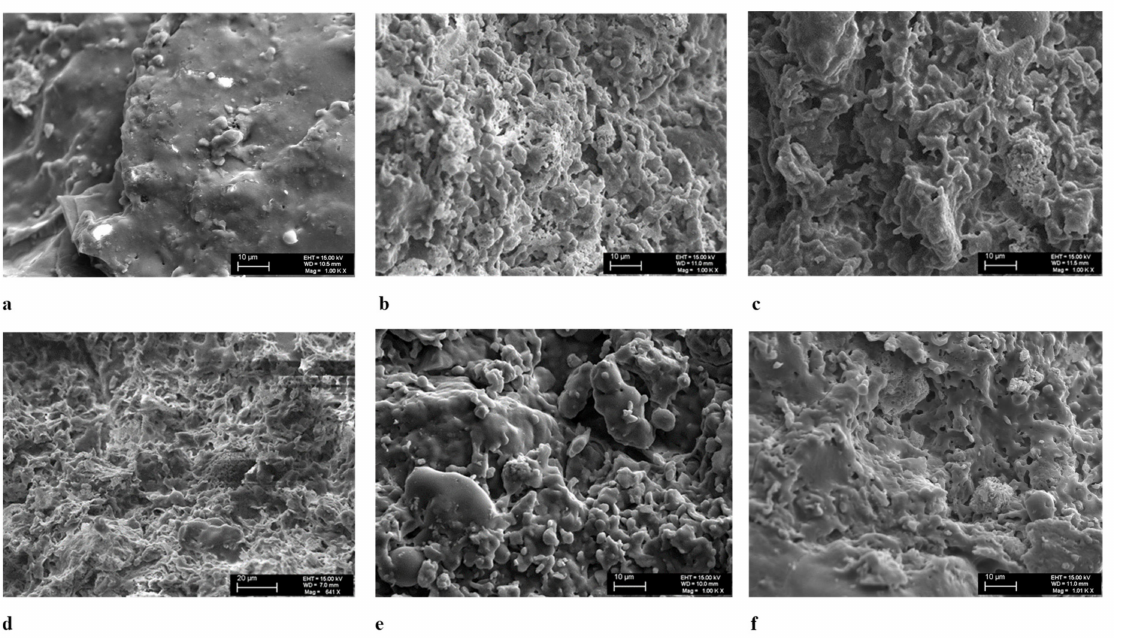
Figure 6. SEM photos of the samples thermally treated at 1050 ◦ C: ( a ) Arumetsa + 40%f(A), ( b ) A + 40% Auvere FA, ( c ) A + 40%DeSOx, ( d ) A + 40%CD, ( e ) Illite + 40%f(I) and ( f ) I + 40%Auvere (magnification: a – c , e , f = 1000 x , d = 640 x